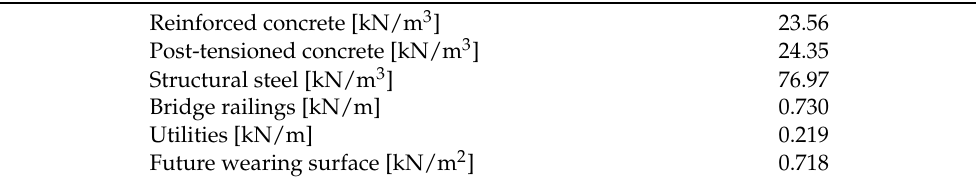
Table 1. Design dead loads.